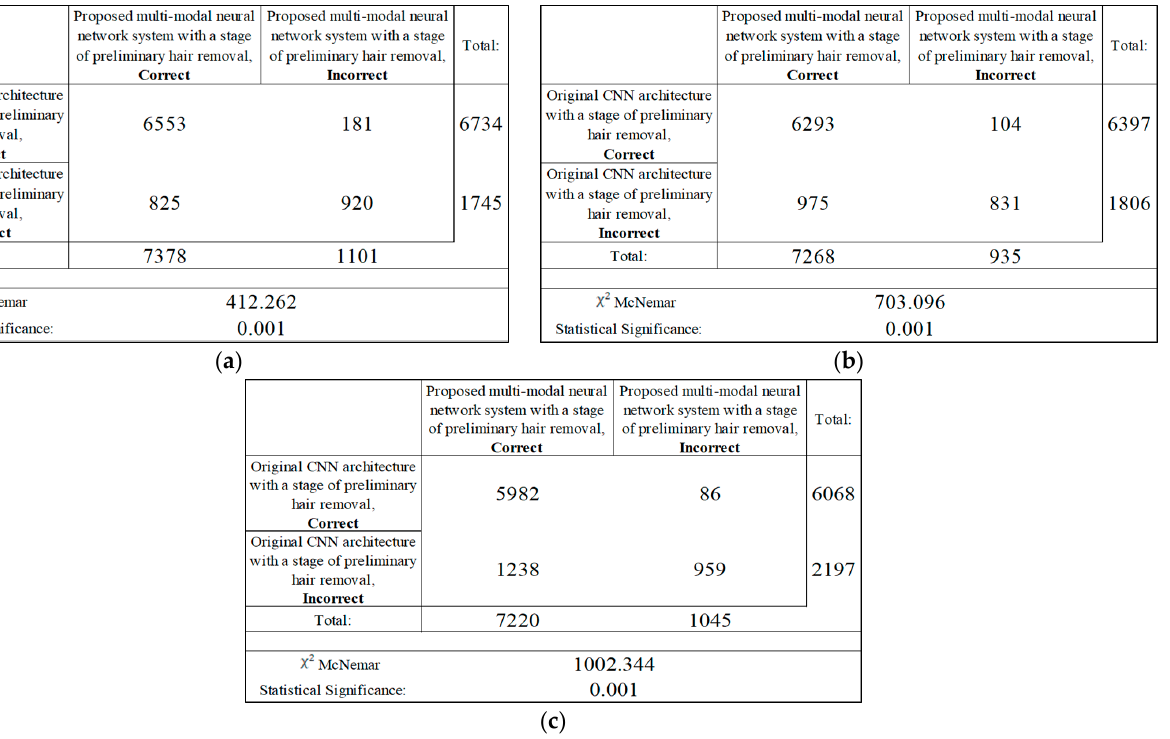
Figure 16. The confusion matrix of the test results of the proposed multimodal neural network system based on CNN is divided into two groups: ( a ) AlexNet; ( b ) SqueezeNet; ( c ) ResNet-101. The 𝜒 (cid:2870) McNemar statistic was calculated as follows: